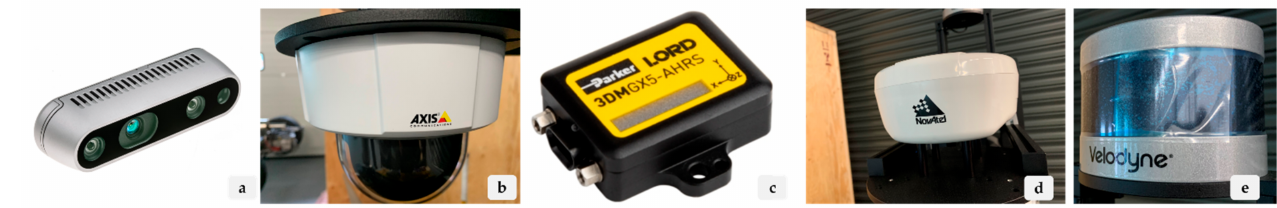
Figure 5. On-board sensors: ( a ) stereo depth camera; ( b ) environmental camera; ( c ) IMU; ( d ) RTK-GPS; ( e ) 3D